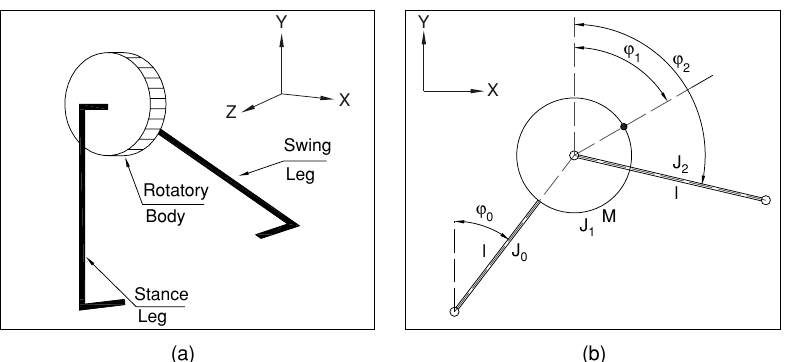
Figure 1 Three-degree-of-freedom biped robot: Perhaps the simplest mechanical system that might walk. (a) Biped robot architecture; (b) Absolute coordinates.